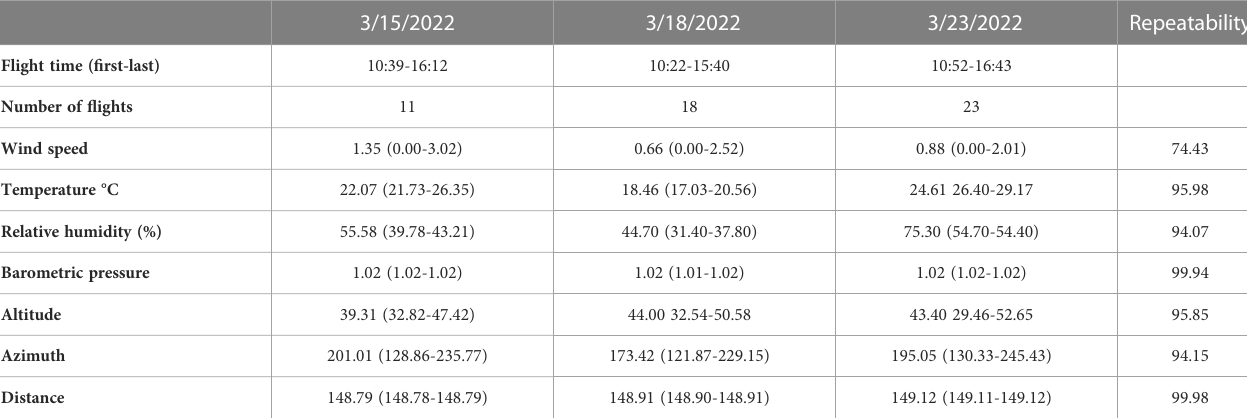
TABLE 1 Weather variables and sun parameters and during fl ight missions on three separate